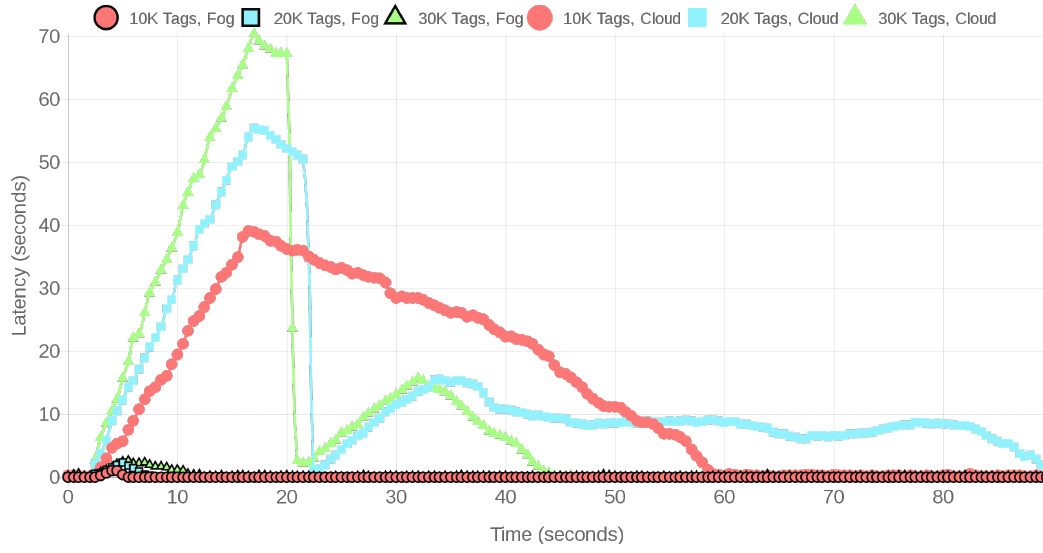
Figure 21. Latencies for the fog and cloud based systems under high